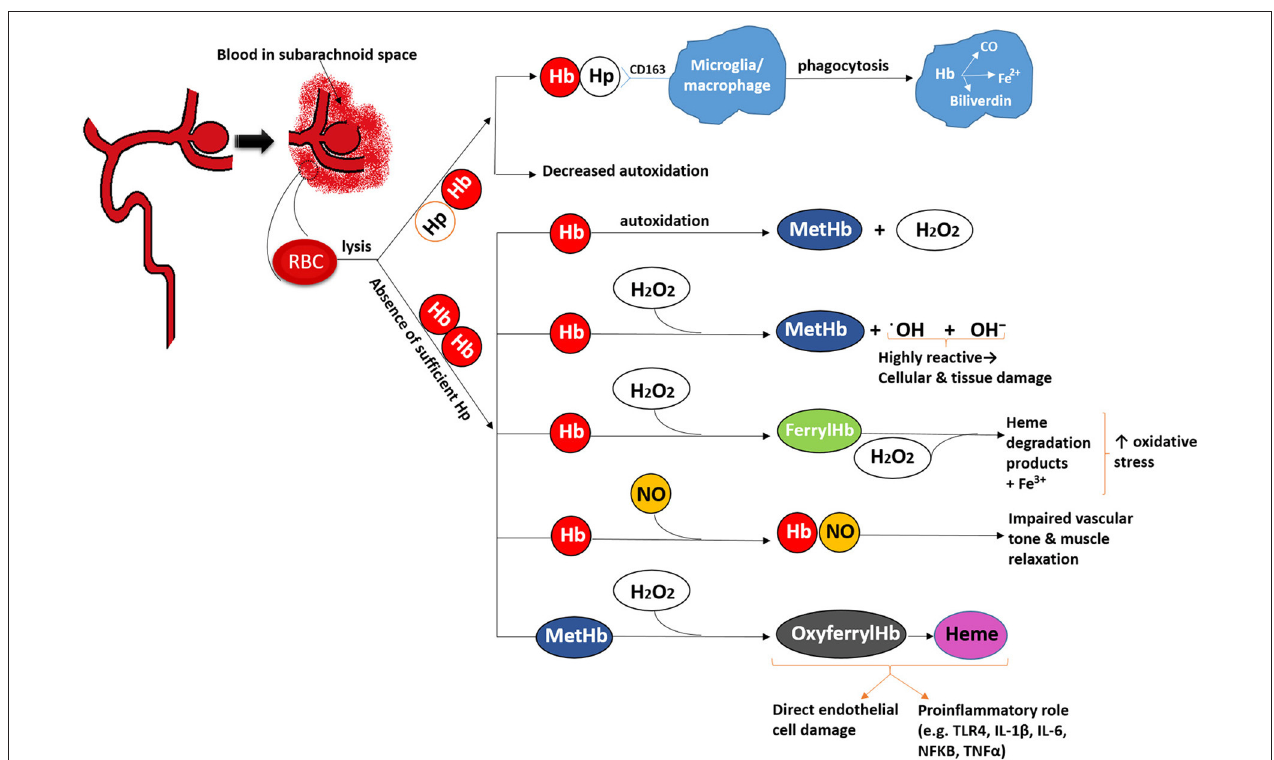
FIGURE 1 | Overall representation of the role of